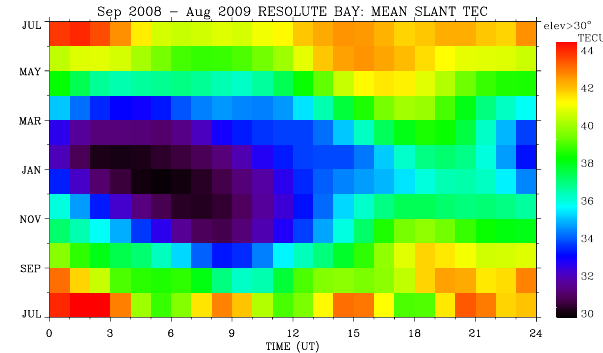
Fig. 7. The mean slant TEC derived from GPS data for Resolute Bay from September 2008 to August 2009. Magnetic local mid- night and noon at Resolute Bay occur around 07:10 and 19:40UT,